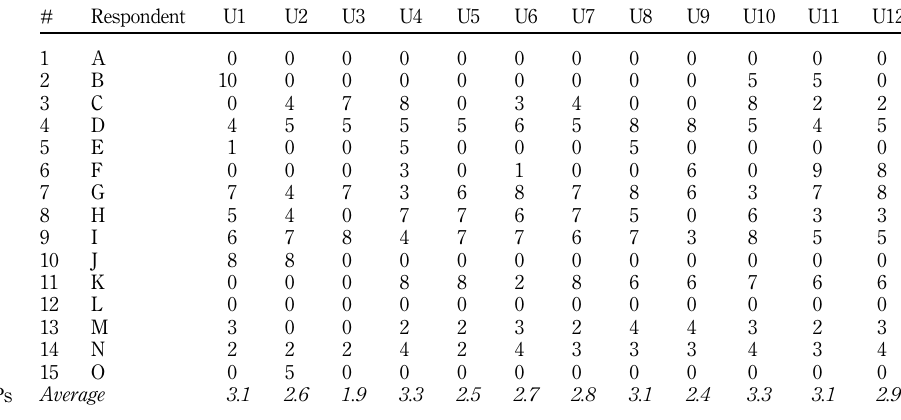
Table 3. Impact of